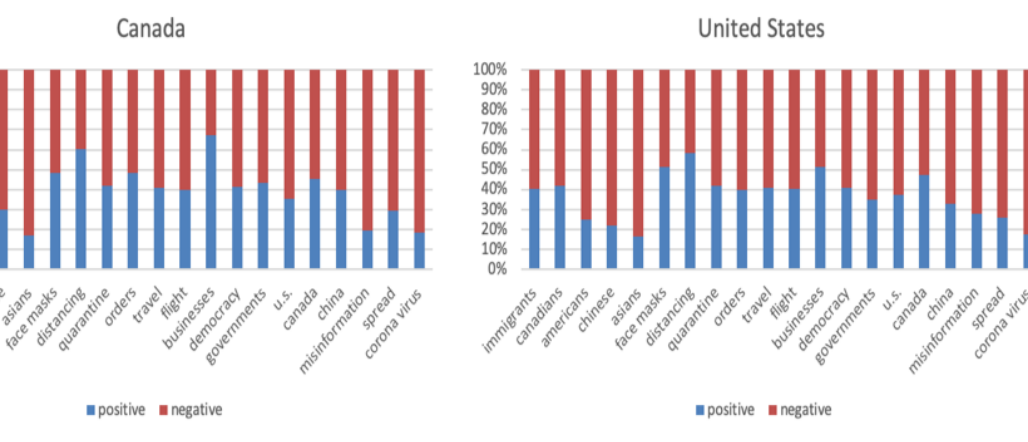
Figure 5. Aspect-based sentiment analysis results for selected aspects. y-axis: the ratio between number of positive occurrences and number of negative occurrences.